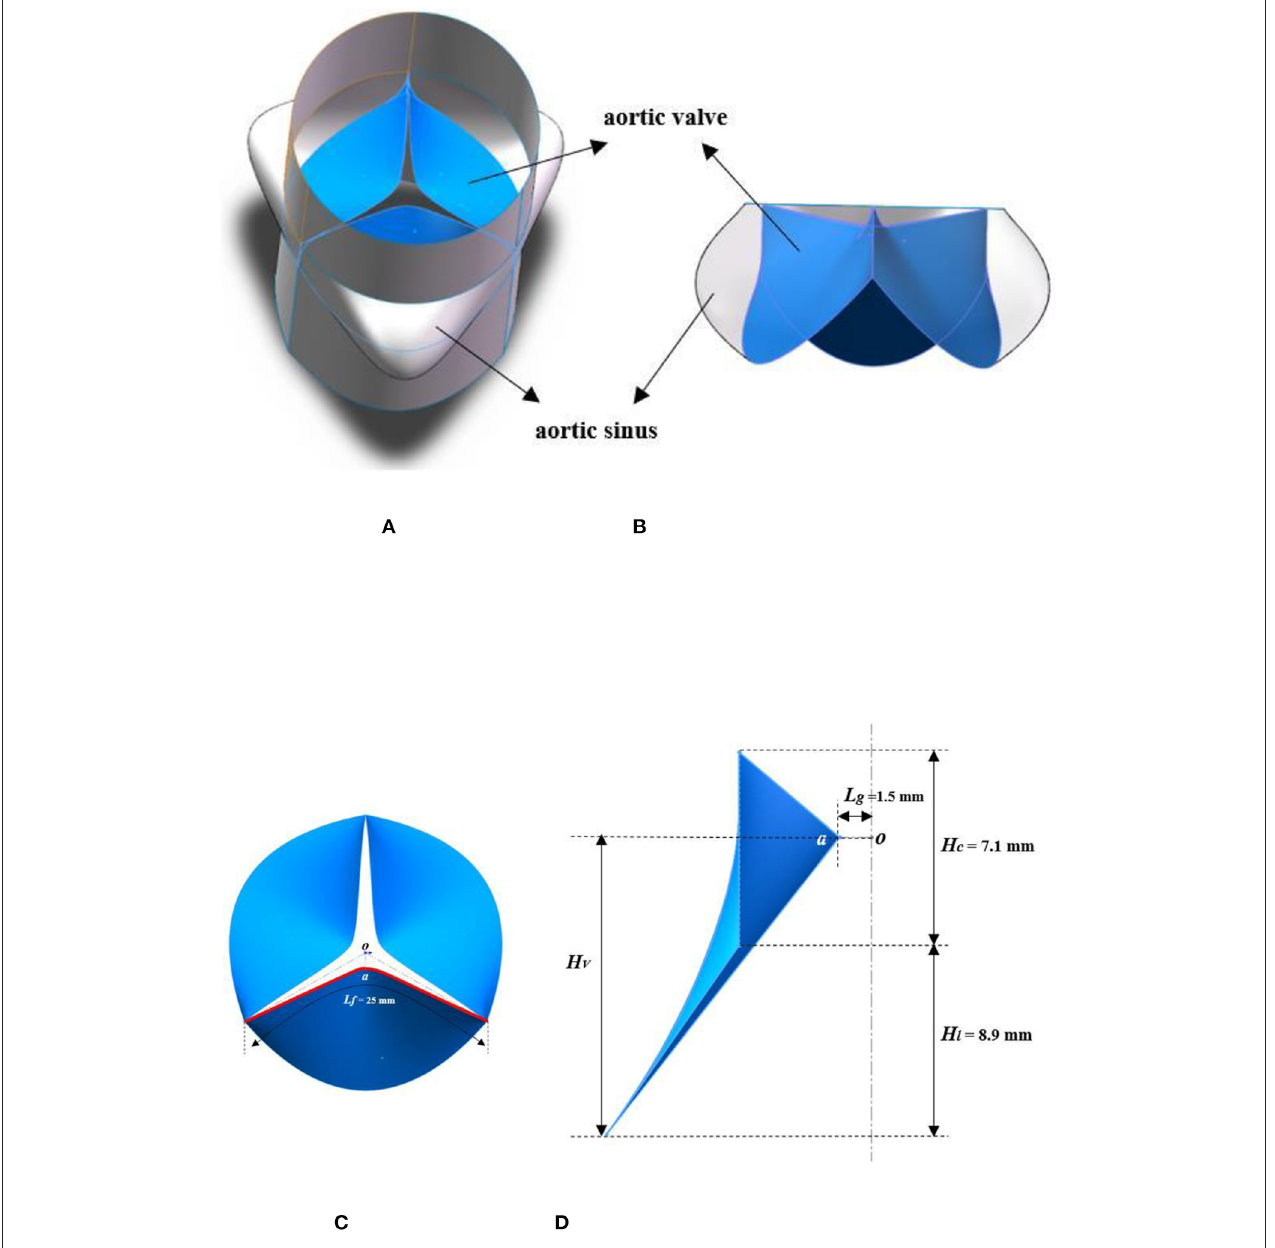
FIGURE 2 | Schematic diagram of the 3D geometry models. (A) 3D structure model of the aortic root; (B) structure of the aortic sinus and leaflet; (C) structural feature of the aortic valve; (D) dimensional characteristics of leaflet. H V , valve height; H l , leaflet height; H c , commissure height; L g , gap length; L f , free-edge length.